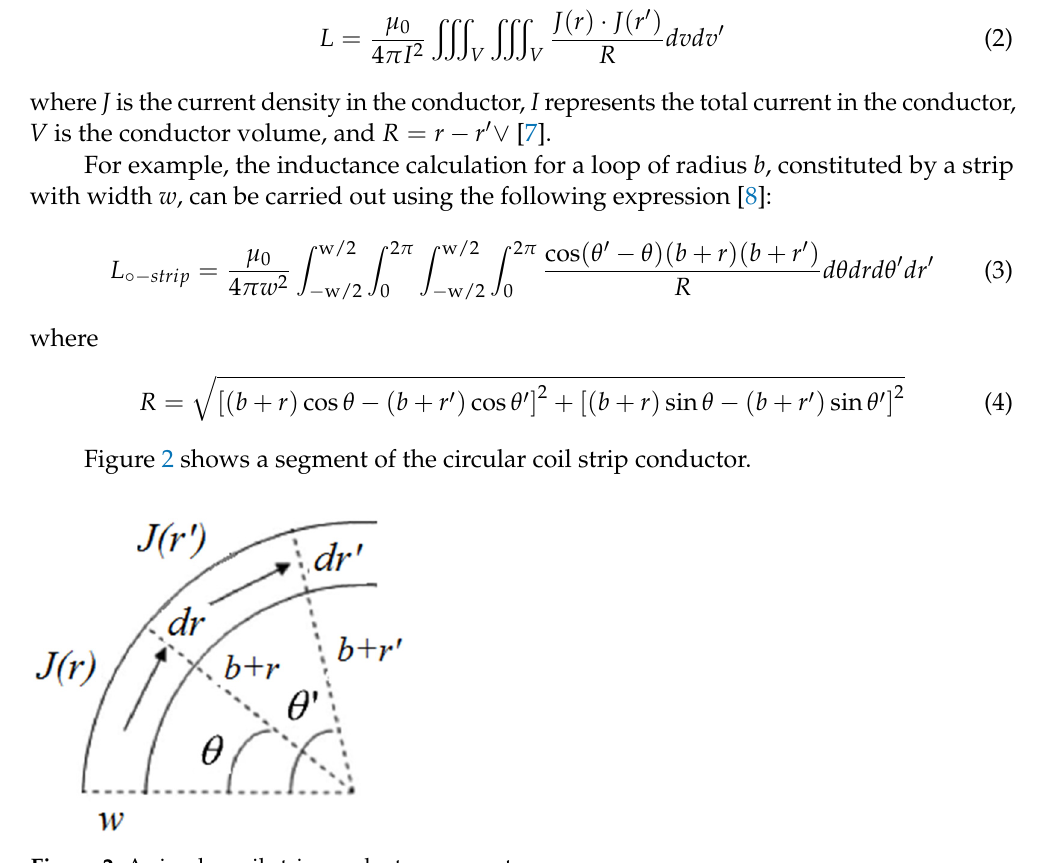
Figure 2. A circular coil strip conductor segment.